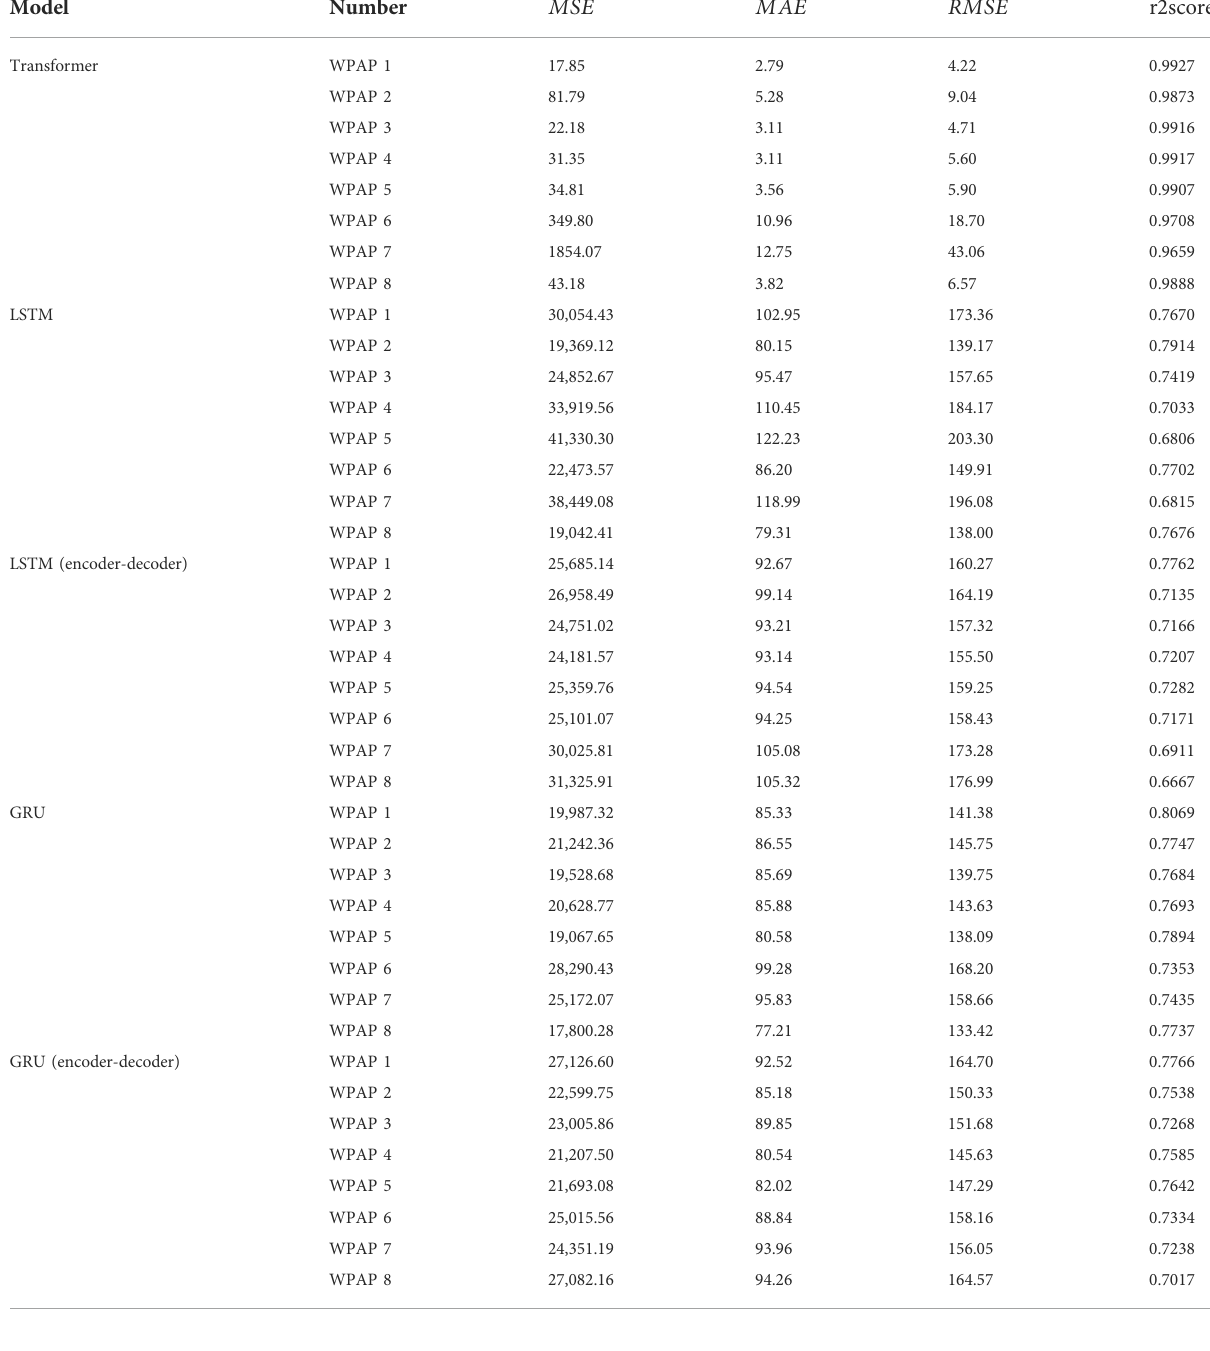
TABLE 1 Each prediction model corresponds to the performance index of each WPAP. Model Number MSE MAE RMSE